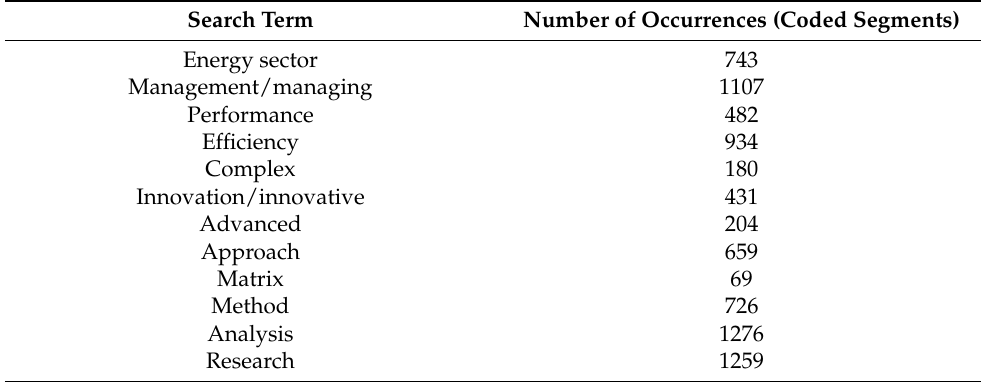
Table 2. Lexical search terms applied to the texts analyzed. Source: own study. Search